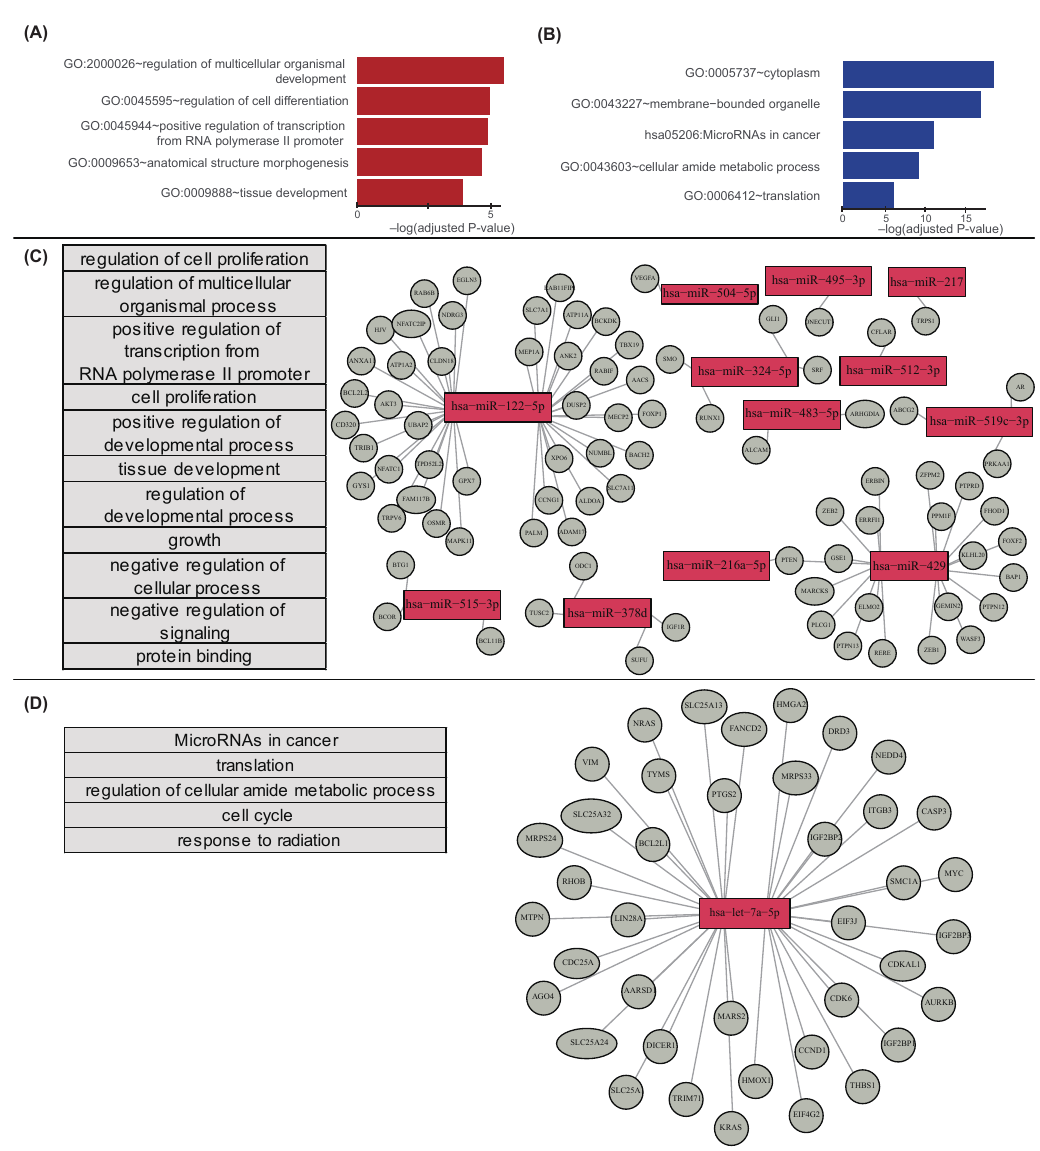
Figure 4. Top five pathways from annotations of target genes of di ff erentially regulated miRNAs after MD. ( A ) Top five pathways of the genes targeted by the up-regulated microRNAs, and ( B ) down-regulated microRNAs. Horizontal bars in ( A , B ) indicate − log ( p -value) calculated using IPA. ( C ) Target genes regulated by the up-regulated microRNAs. ( D ) Target genes regulated by the down-regulated microRNA